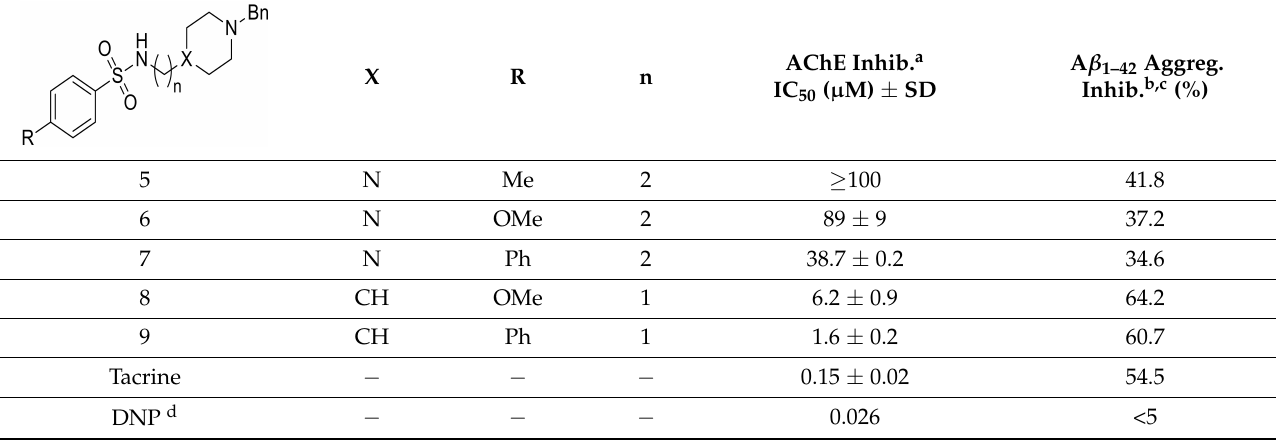
Table 2. Biological activity of the compounds towards the inhibition of AChE and A β 1–42 aggregation.